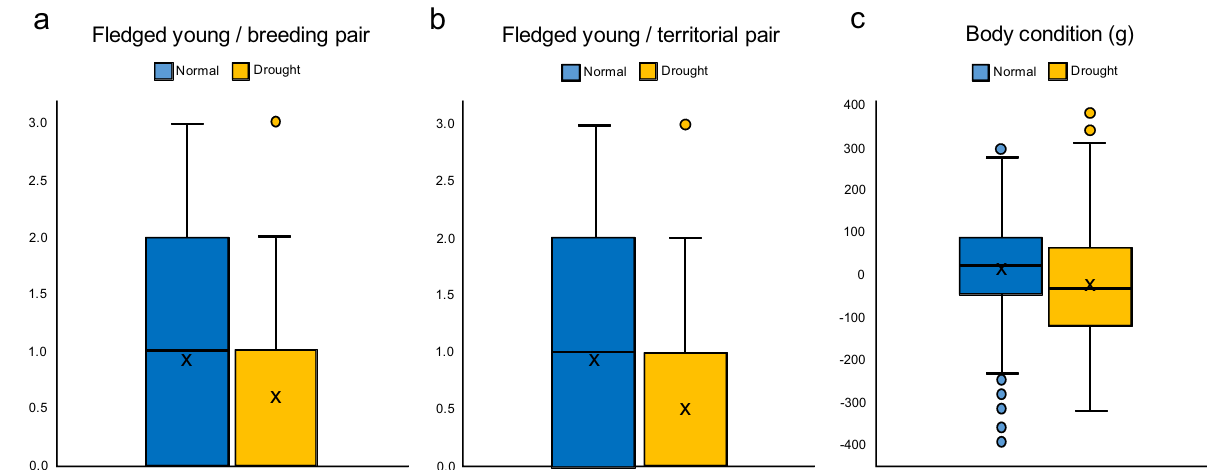
Fig.3|Impactofdroughtonthenumberandqualityoftheoffspringgenerated bytheredkitepopulationofDoñanaNationalPark(southwestSpain). Drought depressedthenumberof fl edgedyoung( a , b ; N =455and181;and N =840and316 breeding attempts for normal and drought years, respectively), as well as their body condition ( c ;massde fi cit: observed mass of anestling compared to the mass